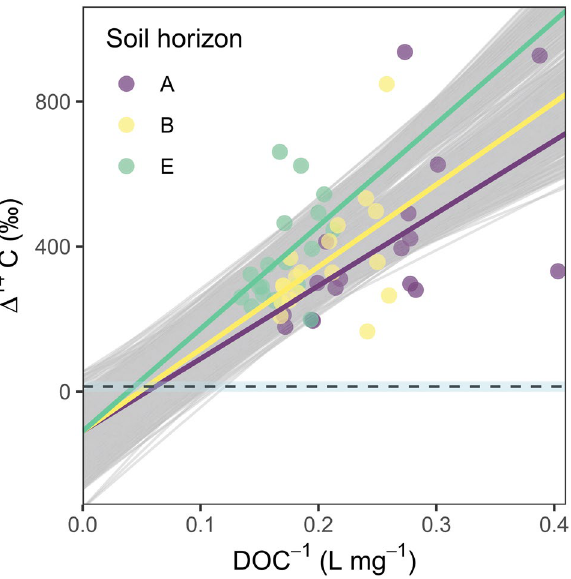
Figure 3. Results from the parametric bootstrapping of the Keeling plot intercepts, showing the first 200 of the 100.000 simulations (grey lines), the original data of the triplicate incubations (dots) and the original fitted multiple linear regression lines (colored lines corresponding to soil horizons). The horizontal black dashed line represents the most current (2015) atmospheric Δ 14 C value of CO 2